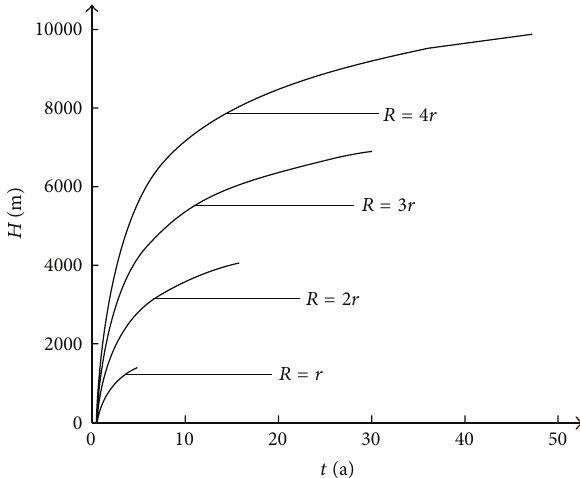
Figure 8: Melting depth of spheres with different radius while Γ 𝑠 = 2